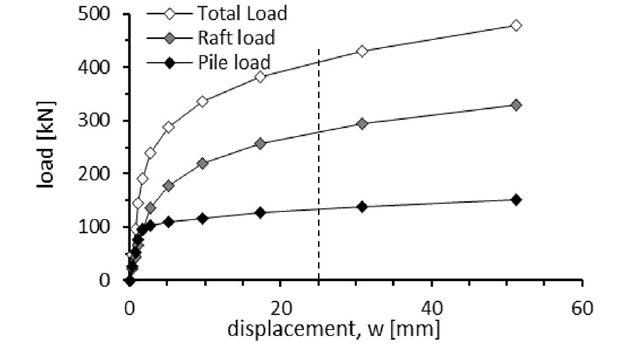
Figure 23. Load-settlement curves for case 16 - L=6m;